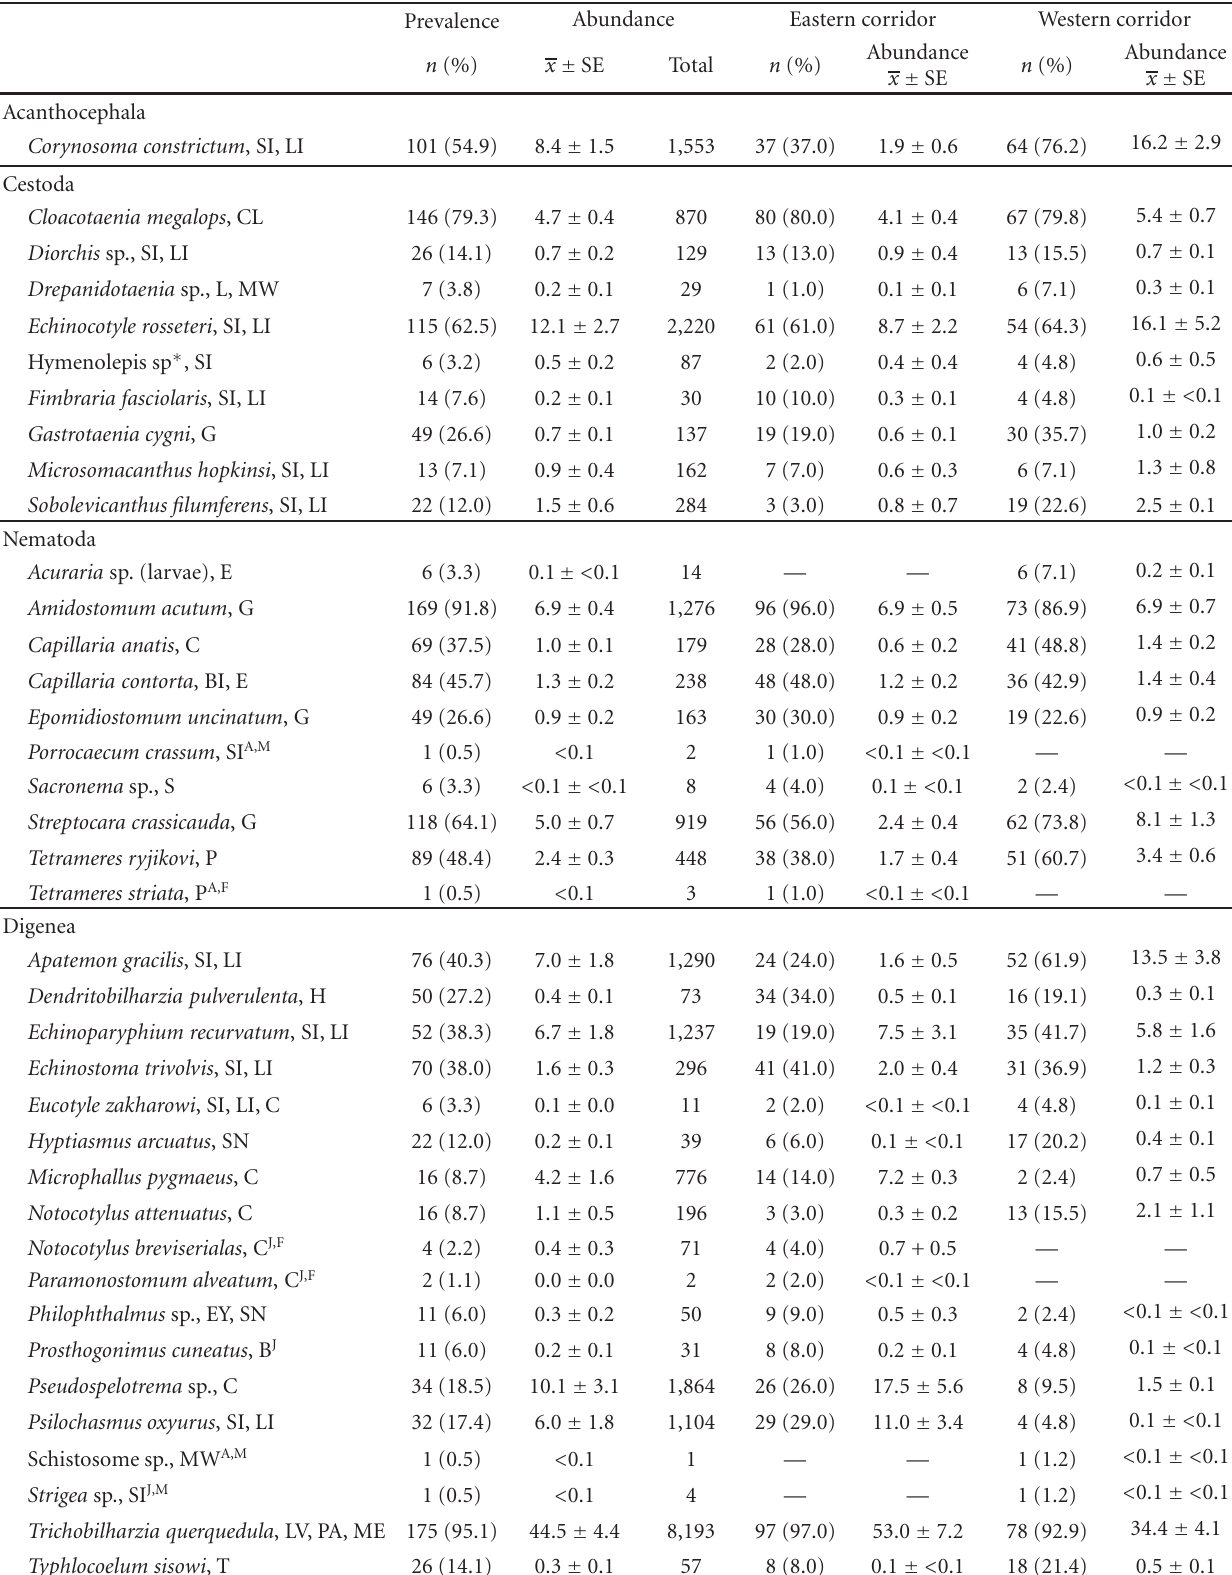
Table 1: Number of hosts infected ( n ), prevalence (%), and mean abundance ( x ± SE ) of 40 helminth species from 184 blue-winged teal ( Anas discors ) collected from eastern and western migratory